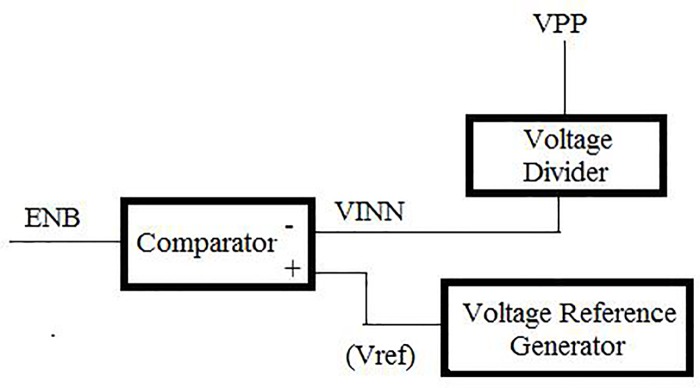
Block diagram of the voltage regulator.